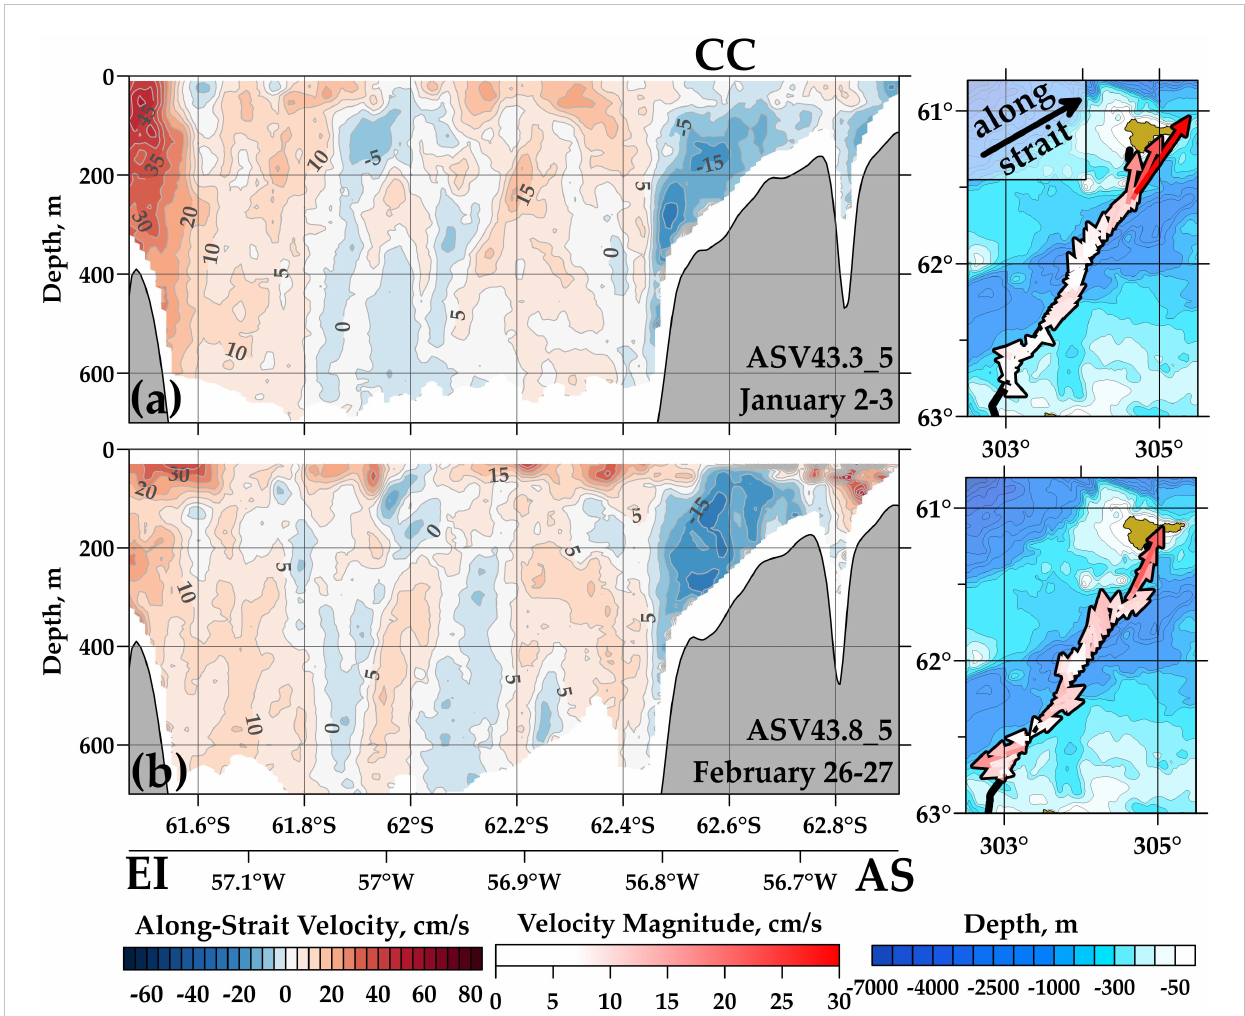
FIGURE 11 Along-strait velocity distributions at two crossings between Elephant Island (EI) and the Antarctic Sound (AS) performed on January 2-3 (A) and February 26-27 (B) , 2017. Positive values of velocity correspond to the east-north-east direction (the exact value is 60° relative to the north; this direction is shown by black arrow in the upper right panel). The velocities were projected to the direction along the strait independently on the orientation of transects. The measurements were performed from the R/V ASV. Locations of the crossings are shown in the right panels together with the depth- averaged SADCP velocities. The ocean bottom is shown by grey color. EI: Elephant Island, AS: Antarctic Sound, CC: Antarctic Coastal